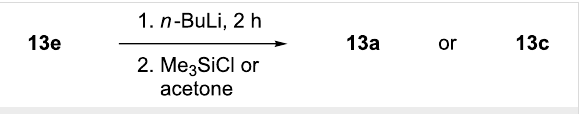
Scheme 6: Stereospecific tin–lithium exchange/quench